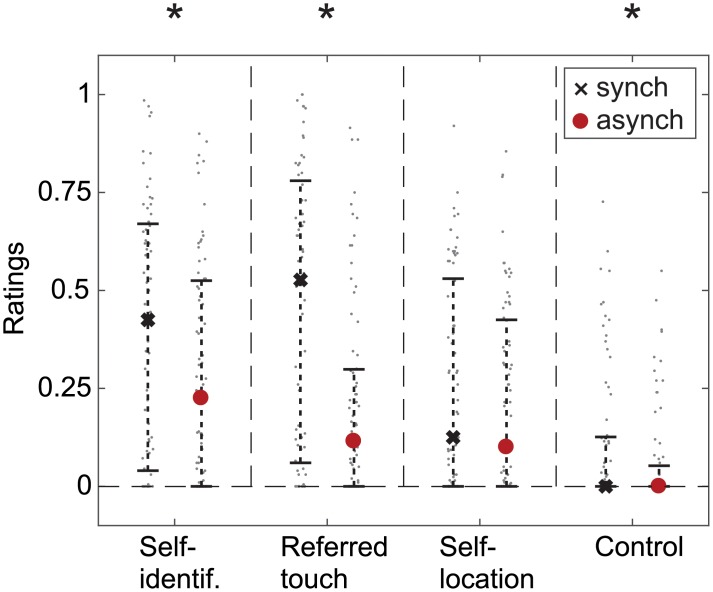
FBI questionnaire results.Median responses for the synchronous (black crosses) and asynchronous (red dots) conditions. Error bars show the interquartile range.